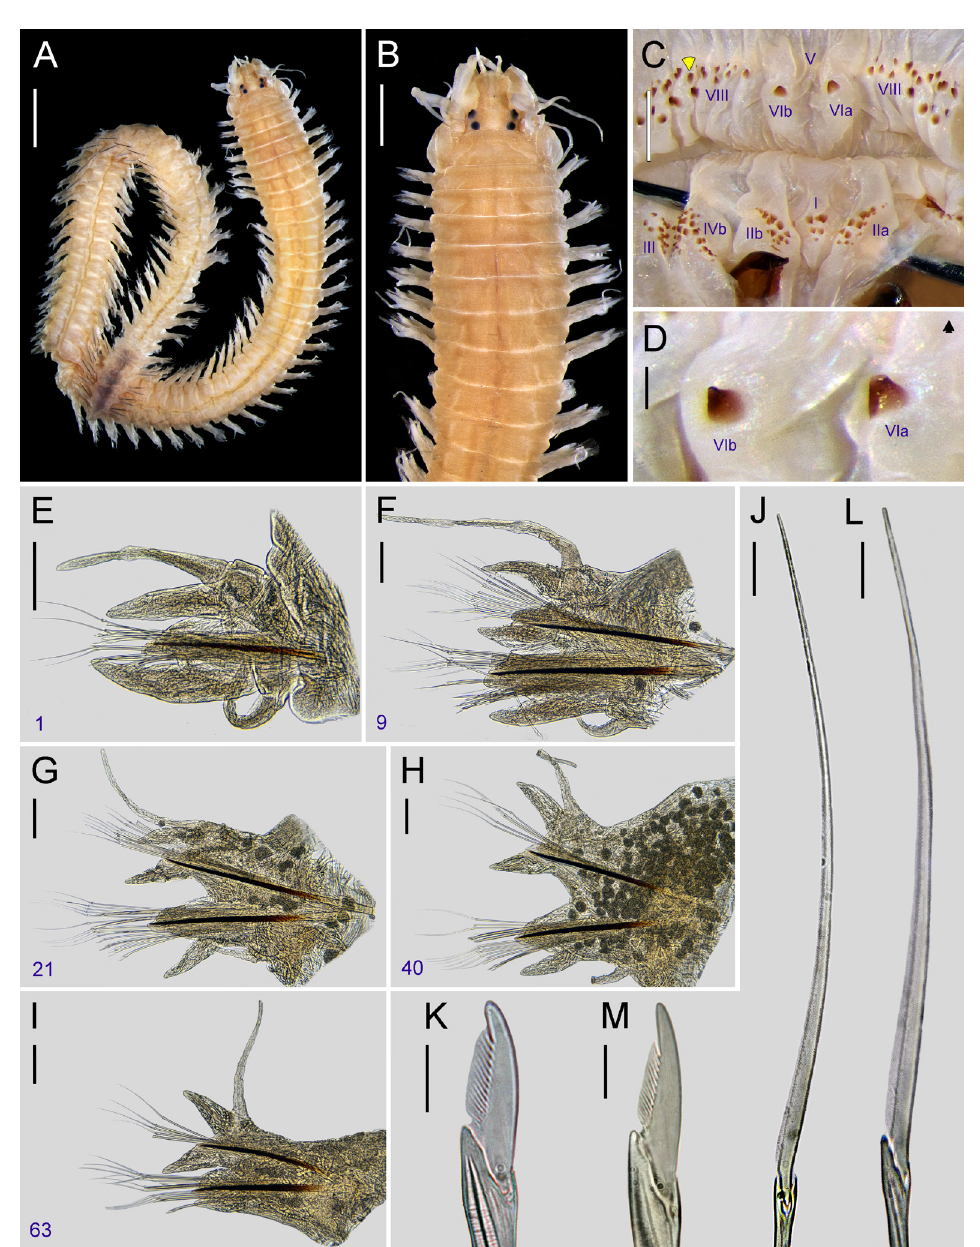
Fig. 5. Neanthes mossambica (Day, 1957). Holotype (NHMUK 1961.16.22) from Morrumbene, Mozambique, atokous female. A . Entire body in dorsal view. B . Anterior end in dorsal view. C . Non- everted pharynx in ventral view (arrow indicates p-bar). D . Area VI of non-everted pharynx in ventral view (arrow pointing anteriorly). E . Left parapodium from chaetiger 1 in posterior view. F . Right parapodium from chaetiger 9 in anterior view. G . Left parapodium from chaetiger 21 in posterior view. H . Right parapodium from chaetiger 40 in anterior view. I . Right parapodium from chaetiger 63 in anterior view with ventral cirri contracted and hidden behind the neuroacicular ligule. J . Homogomph spiniger from notochaetae (chaetiger 9). K . Heterogomph spiniger from subacicular neurochaetae (chaetiger 9). L . Heterogomph falciger from supracicular neurochaetae (chaetiger 9). M . Heterogomph falciger from subacicular neurochaetae (chaetiger 9). Roman numerals refer to the areas and Arabic numbers to chaetigers. Scale bars: A = 2 mm; B = 1 mm; C = 0.5 mm; D = 0.1 mm; E–I = 0.2 mm; J–M = 20